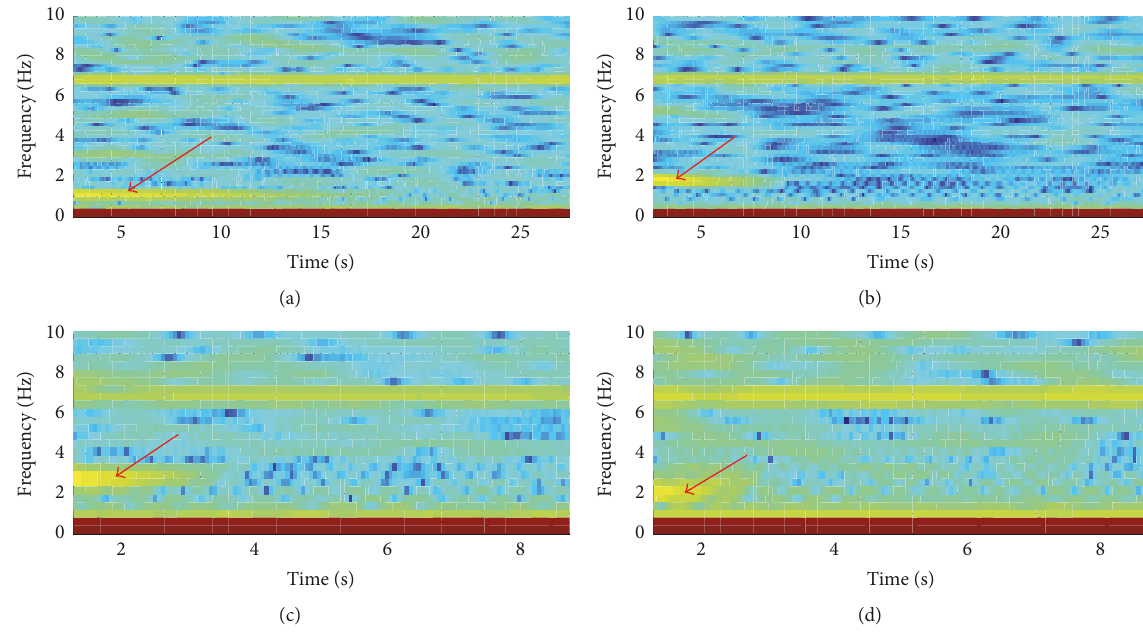
Figure 8: The time-frequency spectra of the velocity of drive side with different springs (𝑞 = 0.285) : (a) spring 1, (b) spring 2, (c) spring 3, and (d) spring 4.